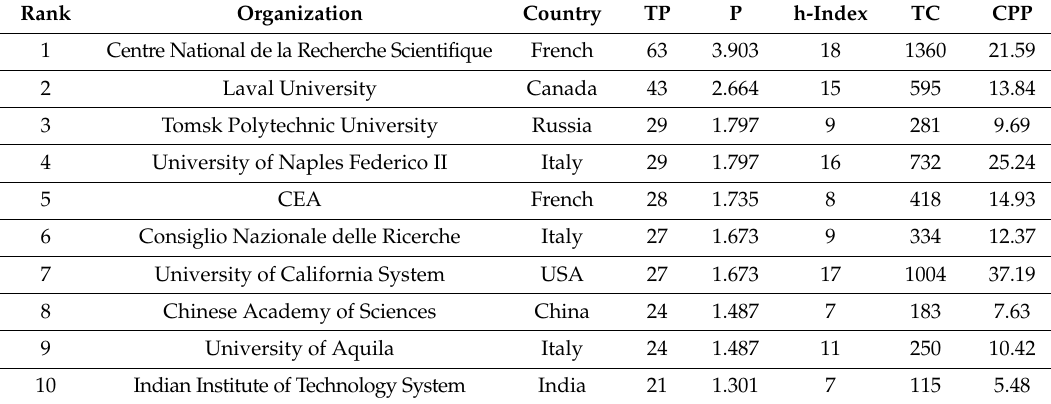
Table 2. Distribution of the top 10 research